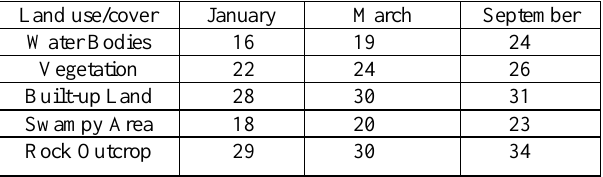
Table 7: Season-wise average temperature across the land use/cover